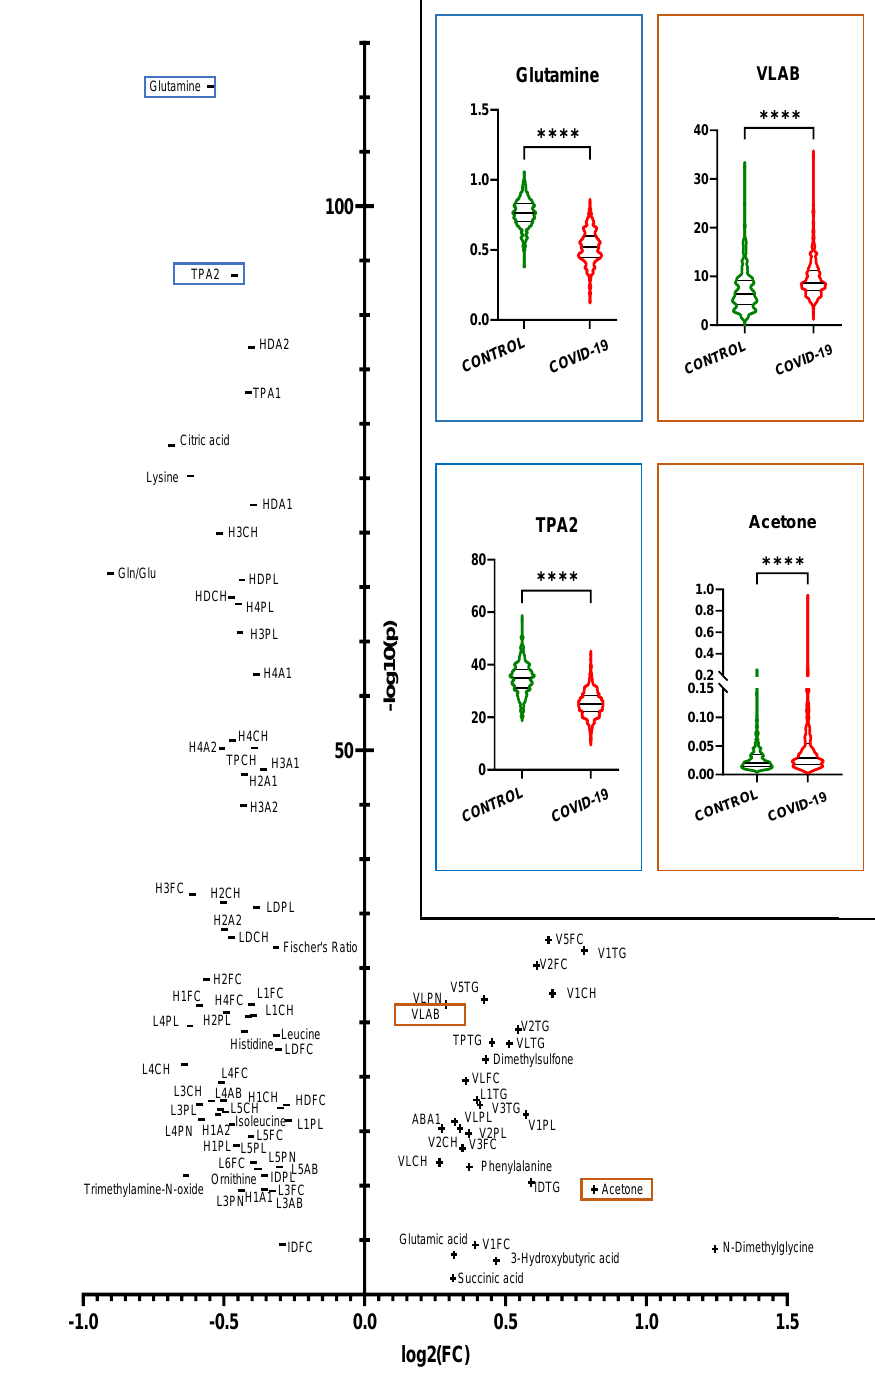
Figure 2. Volcano plot showing the univariate comparison of the whole COVID-19 cohort with healthy controls. The logarithmized fold change (FC > 1.2) is plotted on the X-axis, whereas the Y-axis indicates the significance in the form of the logarithmized p -value (FDR; p < 0.05). In the upper right, exemplary violin plots show the differences in significantly altered parameters. Four asterisks indicate a p -value of